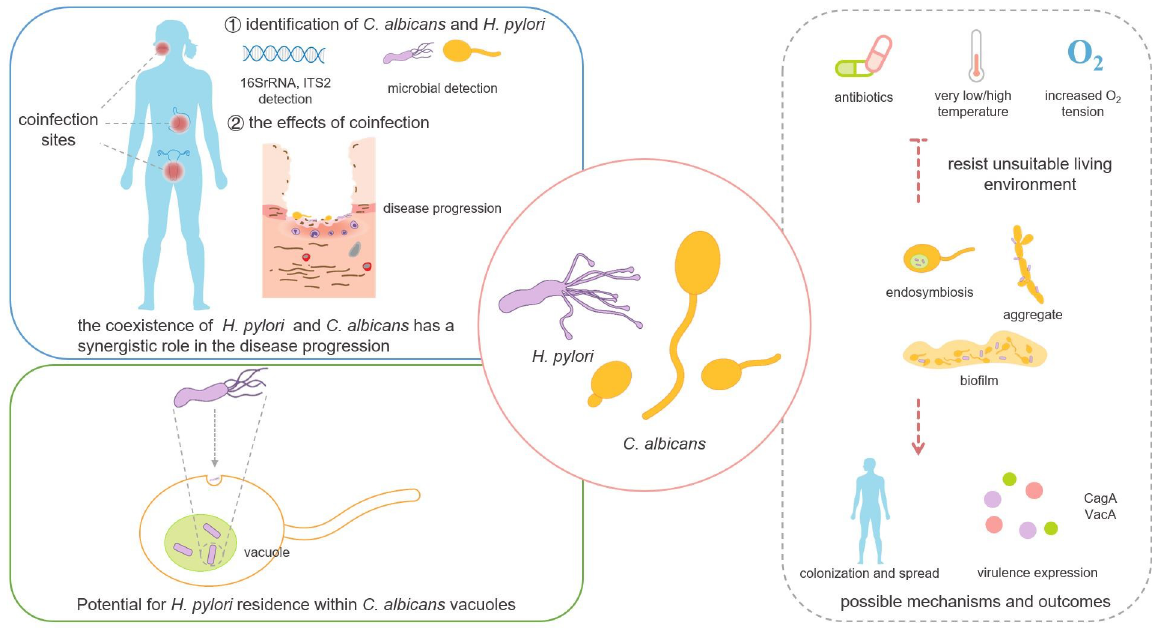
Fig 1. The cross-kingdom interaction between Helicobacter pylori and Candida albicans and the possible mechanisms and outcomes. There is a strong positive correlation between H . pylori and C . albicans in the colonization and synergistic pathogenesis. H . pylori potentially inhabit within C . albicans vacuoles through the endocytosis pathway. The interactions between H . pylori and C . albicans may increase the resistance to the killing effect of antibiotics and unfavorable living environment through endosymbiosis, adhesion, or formation of mixed biofilms, then promote the spread and colonization and increase the virulence factors to affect the occurrence and development of